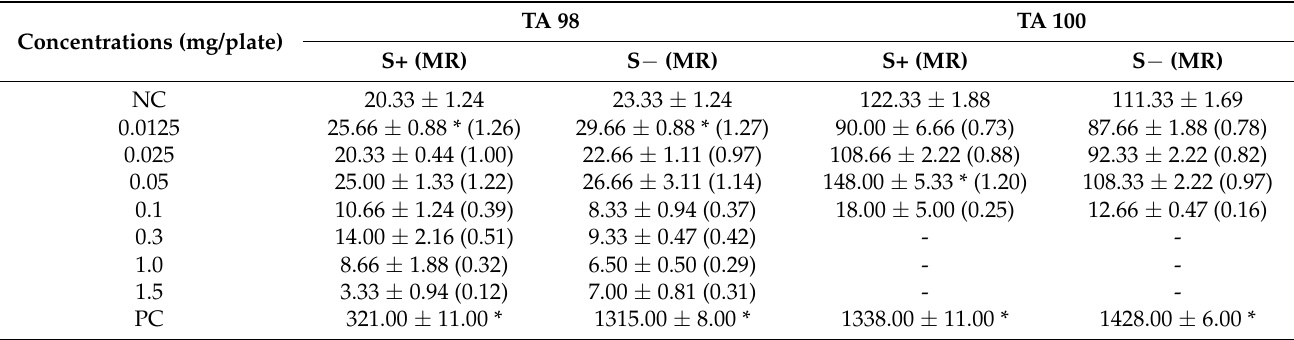
Table 2. Mutagenicity ratio (MR) of the manganese expressed by the mean of reversals/plate ± standard deviation to TA98 and TA100 strains of S. Typhimurium with (S+) and without (S-) metabolic activation. Concentrations